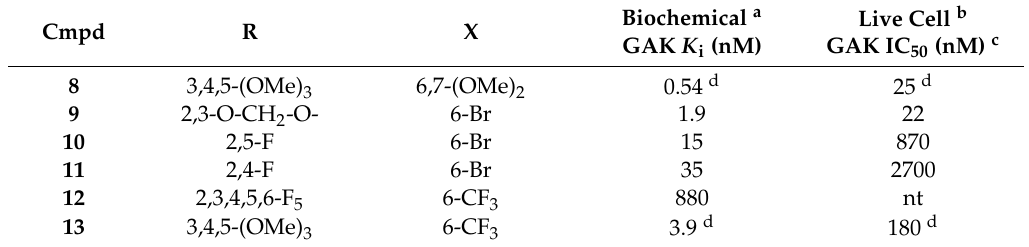
Table 2. GAK a ffi nity measurements and microsomal clearance of initial quinoline series. Cmpd R